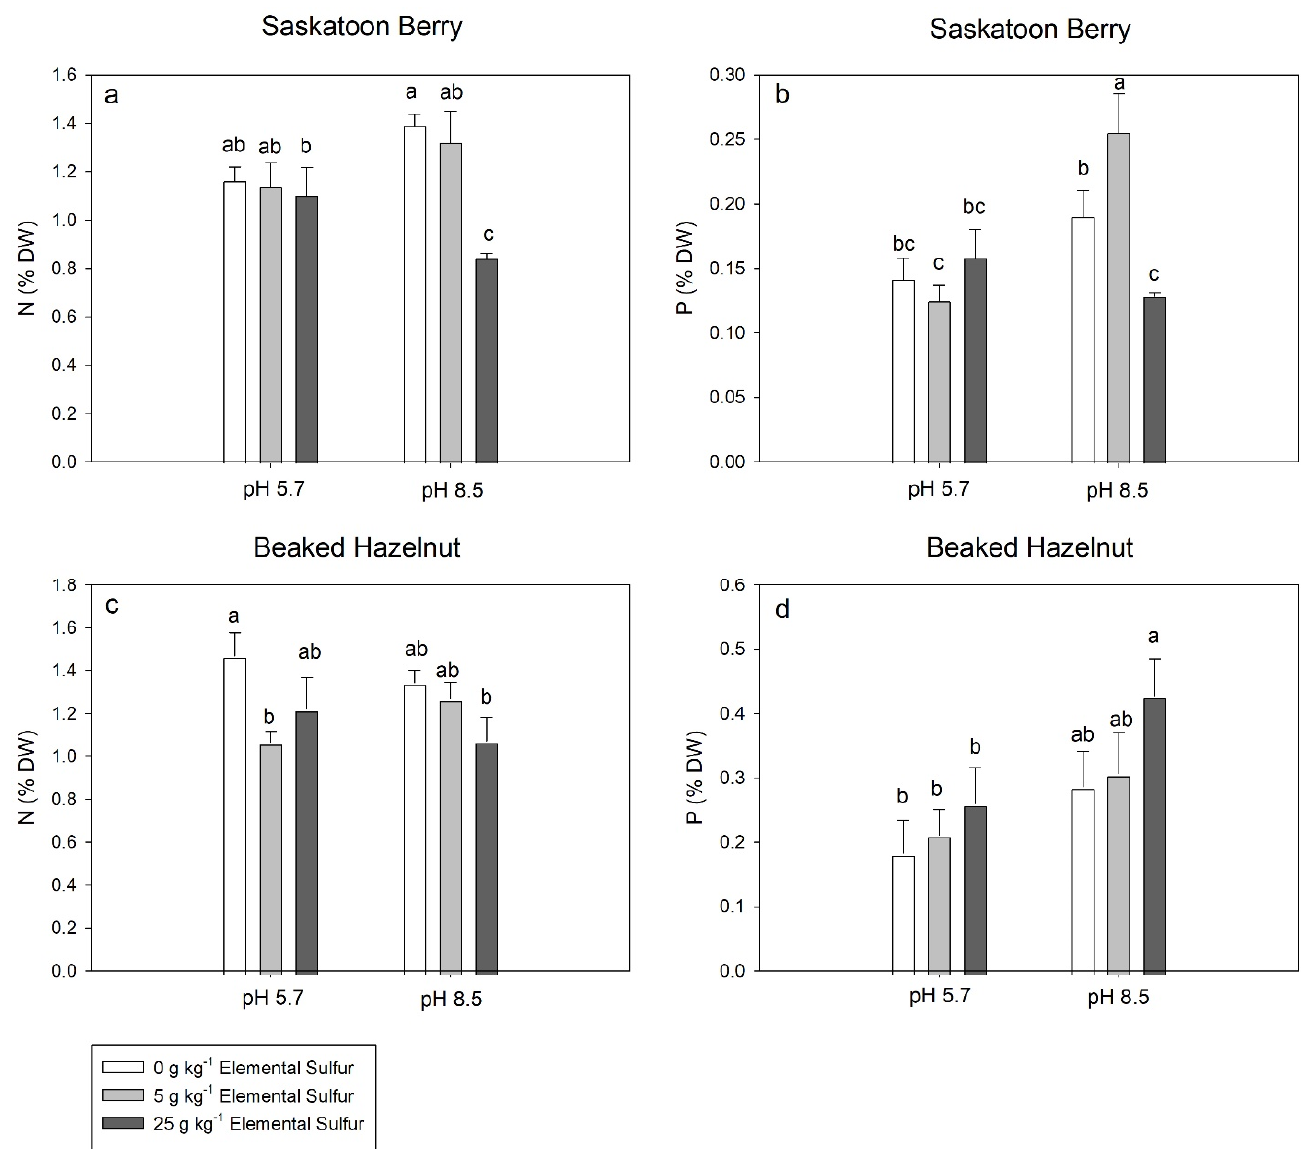
Figure 4. Leaf N and P concentrations in Saskatoon berry ( a , b ) and beaked hazelnut ( c , d ). Plants were grown for two months in the soil of the initial pH 5.7 and 8.5 that was supplemented with 0, 5, and 25 g kg − 1 elemental S. Different letters above the bars indicate significant differences ( α = 0.05) between treatments determined by Tukey HSD test. Means ( n = 6) ± SE are shown.